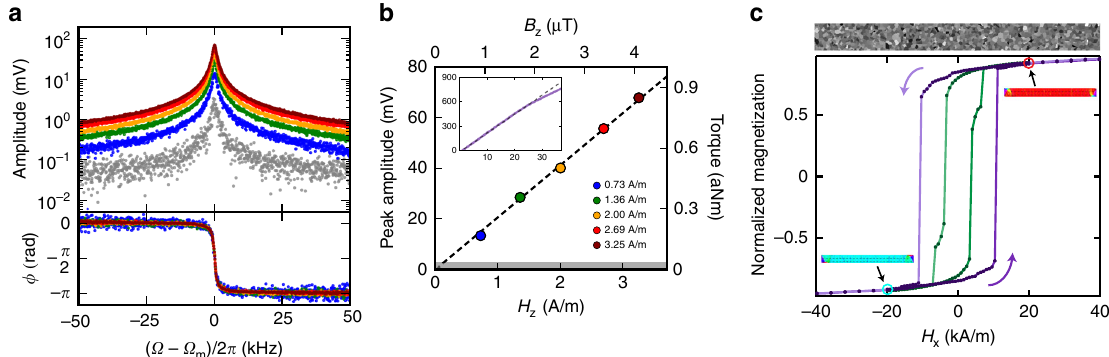
Fig. 2 Magnetic actuation and sensing. a Amplitude of the thermomechanical (grey) and magnetically actuated (coloured) torsional resonance, with corresponding phase of the driven traces. Colours in a correspond to the drive magnetic fi eld plotted in b , which shows the relationship between the peak mechanical signal amplitude (left axis) and calibrated torque (right axis), vs. the magnetic drive. The grey band represents the thermomechanically limited minimum fi eld sensitivity of 0.12 A m − 1 , corresponding to a thermal torque of 32 zNm. Inset, with the same axes, shows the deviation of the continuously measured peak response (purple) from the linear fi t extrapolated from low fi eld (dashed). Above 25 A m − 1 the optical resonance is shifted due to heating from the drive chip. c Simulated magnetization (normalized to M s ) hysteresis (see Methods for details) with in-plane domain structure at circled points. At high fi elds the needle is nearly saturated, with triangular domains at each end. As the fi eld is lowered these domains move toward the centre, reducing the net magnetization. For a uniform iron fi lm (green trace) at zero fi eld, the remanent magnetization corresponds to 79% of the saturation moment. Adding polycrystalline grains, as shown above c , increases the remanent magnetization to 85%, as seen in the purple